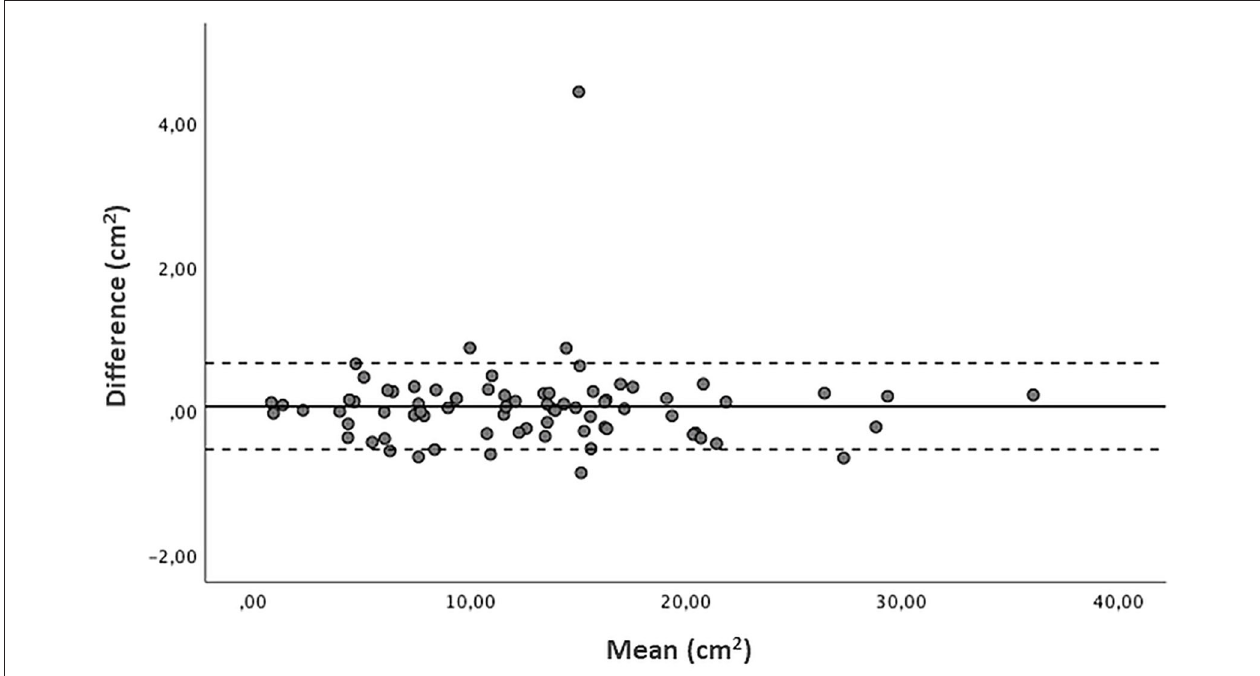
FIGURE 4 | Relation between V T and RR. Z-Score Tidal Volume (V T ) and Z-Score Respiratory Rate (RR) show an inverse relationship (B − 0.9, p < 0.001).